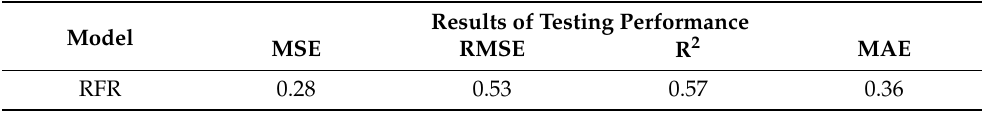
Table 9. The testing phase (split tensile strength) with available RFR models’ yielded statistical data from the applied prediction